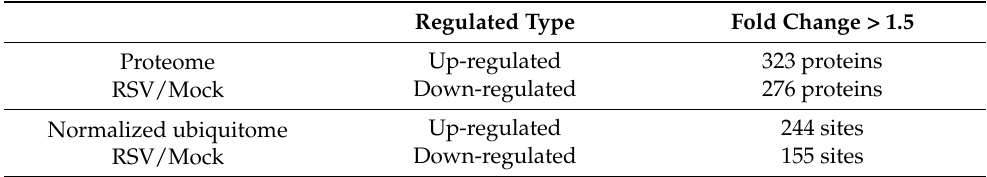
Table 2. Overview of proteins and Kub sites regulated during RSV infection in proteome and normalized ubiquitome data.